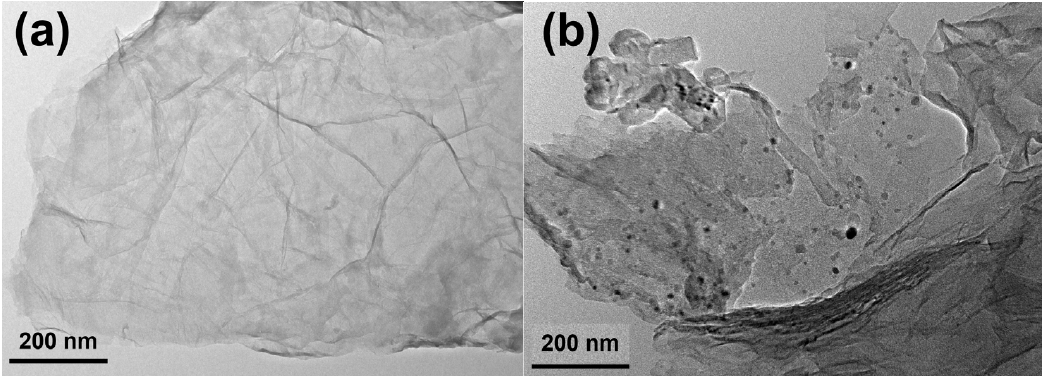
Figure 5. TEM results of ( a ) neat GO and ( b ) HBP-m-GO.